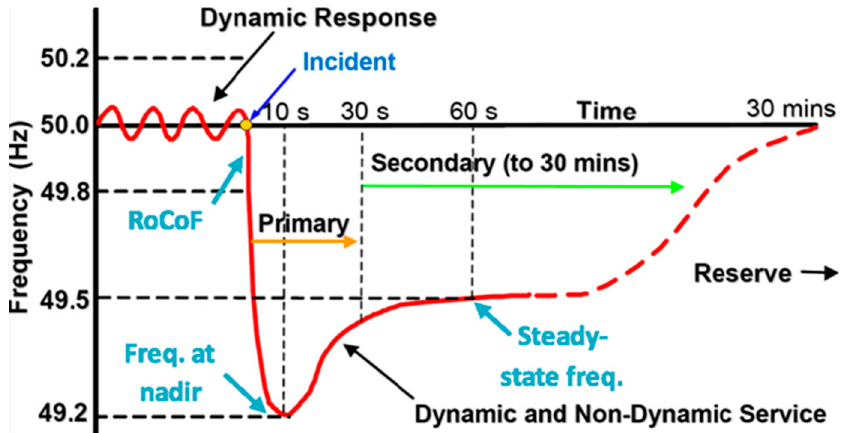
Figure 4. Frequency deviation following of activation of dynamic and non-dynamic ancillary services 325 by a thermal power plant, linked to the AGC. 326